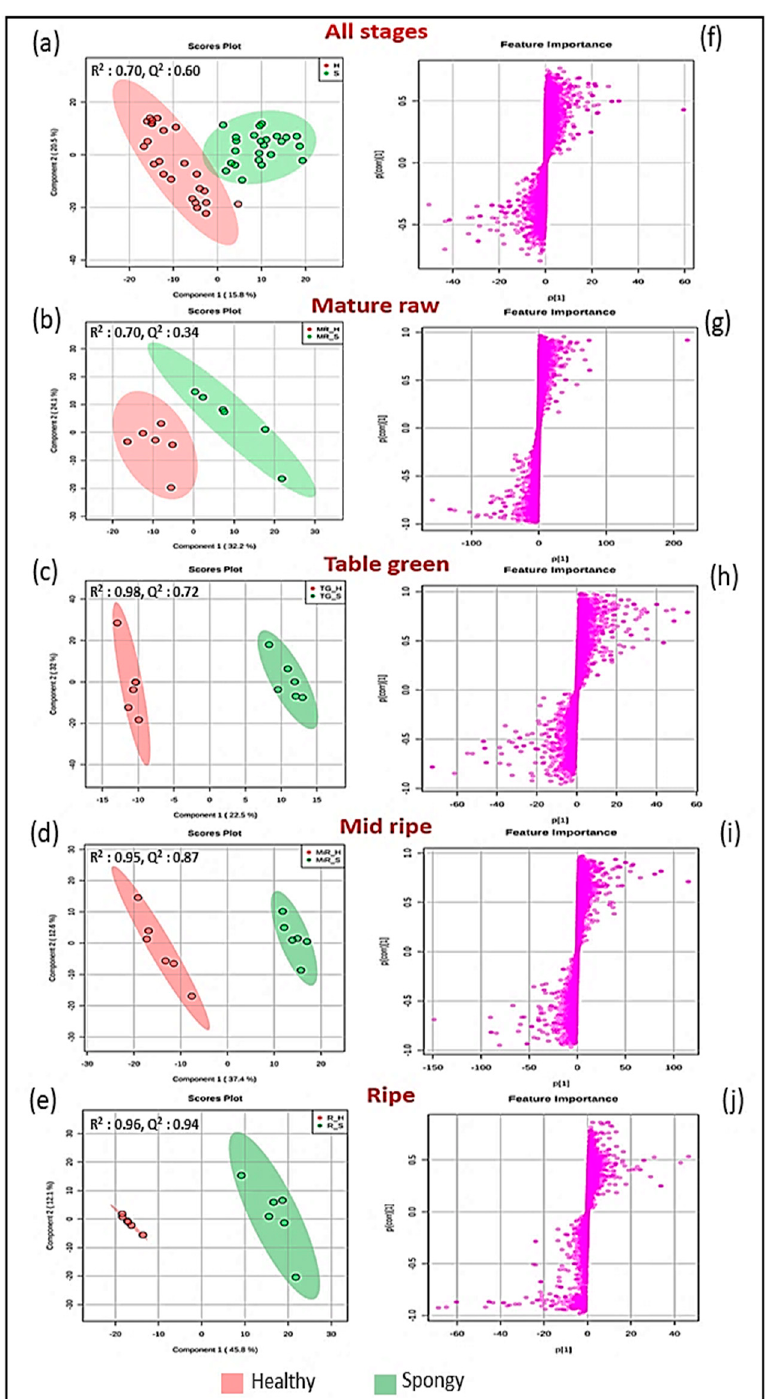
Figure 5. Pairwise metabolite feature comparison. PLS-DA Score plot ( a to e ) and corresponding S-Plot ( f to j ) obtained from metabolic profile considering healthy and spongy tissue at all the stages combined and four ripening stages (mature raw, table green, mid ripe and ripe) individually of the mesocarp of mango.